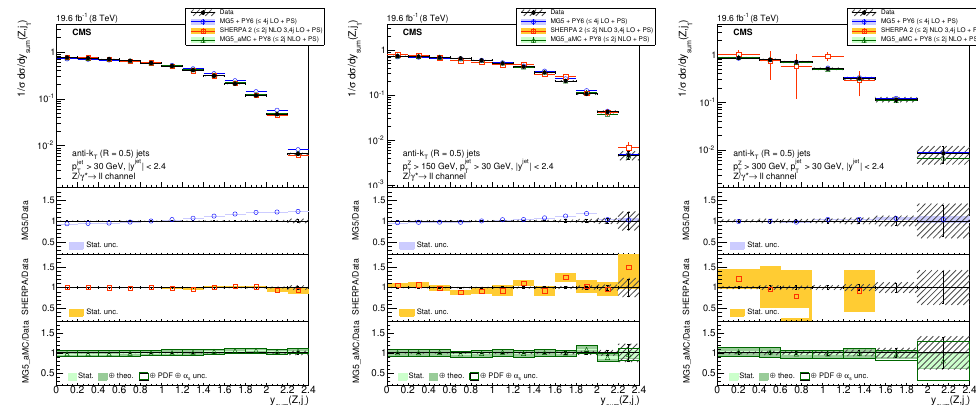
Figure 13 . The normalised di(cid:11)erential cross section for Z ( ! ‘‘ ) + jets ( N jets (cid:21) 1) production measured as a function of the y sum of the Z boson and the leading jet compared to the predictions calculated with MadGraph 5 + pythia 6, sherpa 2, and mg5 a mc + pythia 8. The cross section is measured inclusively with respect to the Z boson p T and for two di(cid:11)erent p T (Z) thresholds. The ratio of the prediction to the measurements is shown for (left) p T > 0 GeV, (middle) p T > 150 GeV, and (right) p T > 300 GeV. The lower panels show the ratios of the theoretical predictions to the measurements. Error bars around the experimental points show the statistical uncertainty, while the cross-hatched bands indicate the statistical and systematic uncertainties added in quadrature. The boxes around the mg5 a mc + pythia 8 to measurement ratio represent the uncertainty on the prediction, including statistical, theoretical (from scale variations), and PDF uncertainties. The dark green area represents the statistical and theoretical uncertainties only, while the light green area represents the statistical uncertainty alone.